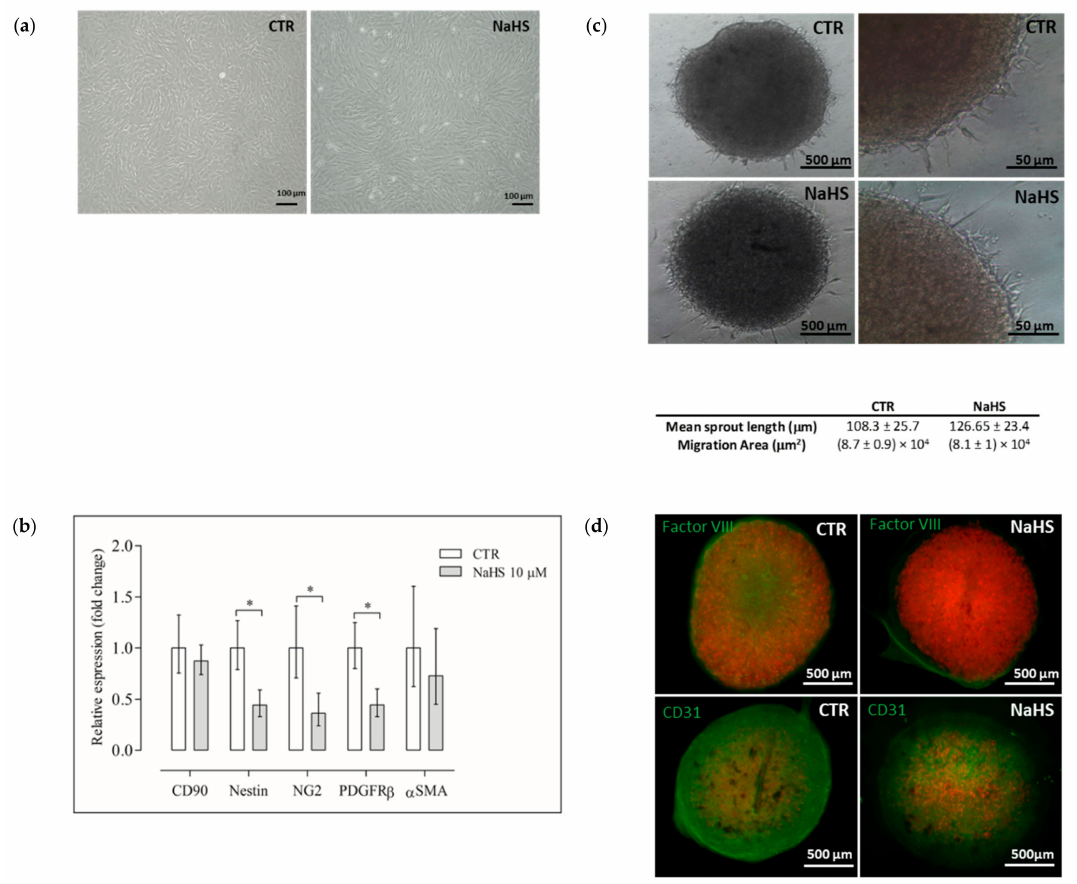
Figure 4. E ff ect of NaHS on the pVW–MSC gene expression profile and angiogenic attitude; ( a ) the representative images of pVW–MSCs morphology in control (CTR = DMSO 0.01% v / v ) and NaHS-treated cells (10 µ M) after 21 days of culture; scale bar = 100 µ m; ( b ) the gene expression profile of some typical pVW–MSC markers CD90, Nestin, NG2, PDGFR β , α SMA, in pVW–MSCs cultured 21 days with NaHS (10 µ M) and their control (CTR). Data represent the mean ± the range of relative expression of three independent experiments. Data were analyzed using the Student’s t -test, significant di ff erences are indicated as ( p < 0.05). The relative expression (fold change) was calculated using the 2 − ∆∆ Ct method in relation to the control cells, ( c ) the representative images of pVW–MSC spheroids obtained through a 3D in vitro angiogenesis spheroid assay after 21 days of culture in control (CTR) and NaHS cell exposure (10 µ M); the quantification of morphometric parameters: (the mean sprout length and the migration area) were reported, data represent the mean ± standard deviation of three independent experiments. The left images scale bar = 500 µ m, right images scale bar = 50 µ m; ( d ) the immunofluorescence analysis of pVW–MSC’s spheroids with endothelial markers Factor VIII and CD31(both green) in the control (CTR) and NaHS treatments (10 µ M), and the nuclei were stained with propidium iodide (PI) (red) scale bar = 500 µ